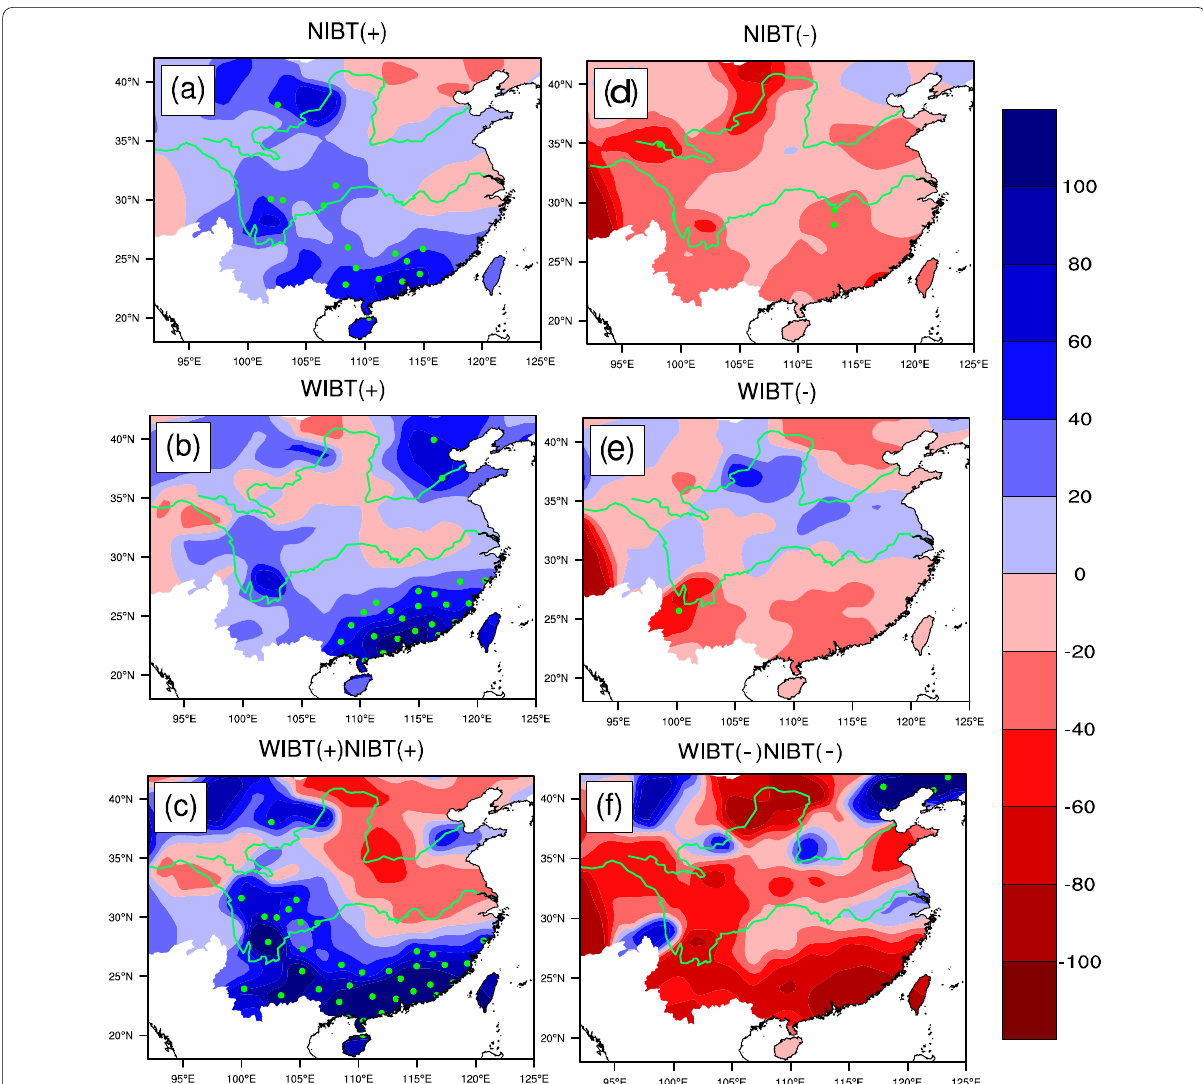
Fig. 7 Composite percentage (units: %) of winter precipitation anomalies for the years of ( a ) higher NIBT indices, ( b) higher WIBT indices, and c both higher NIBT and WIBT indices. (d) –(f) as in ( a – c ) respectively, but for lower NIBT and WIBT indices. Green dots denote precipitation anomalies significant at the 99% confidence level. Note that there are no significant anomalies in (f) since there is only one year (i.e., 2009) with both NIBT and WIBT indices lower than 0.75 standard −